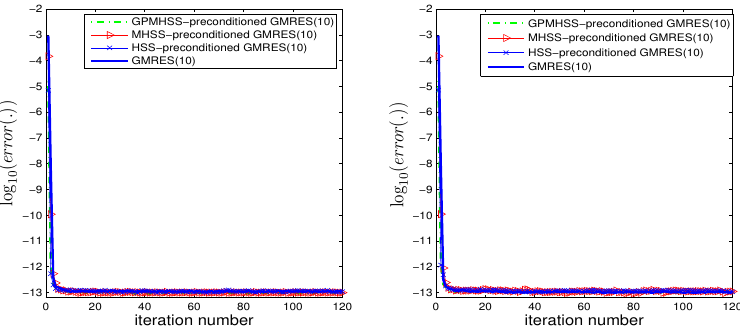
Figure 8. The log 10 of the residual error versus iteration number for Example 2, with n = 20 × 20 (left) and n = 40 × 40